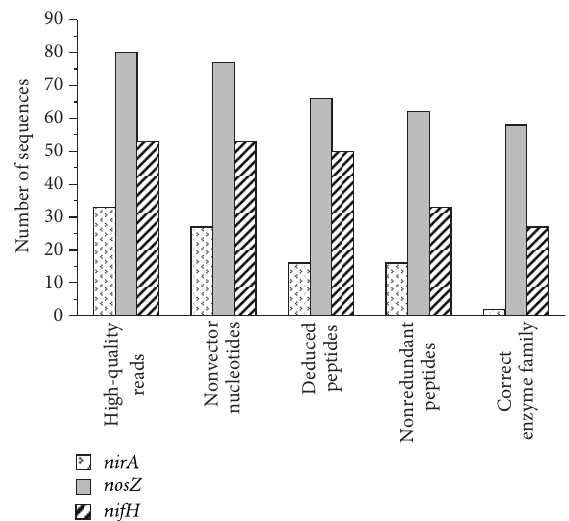
F 3: Sieving of sequences aer cloning of PCR